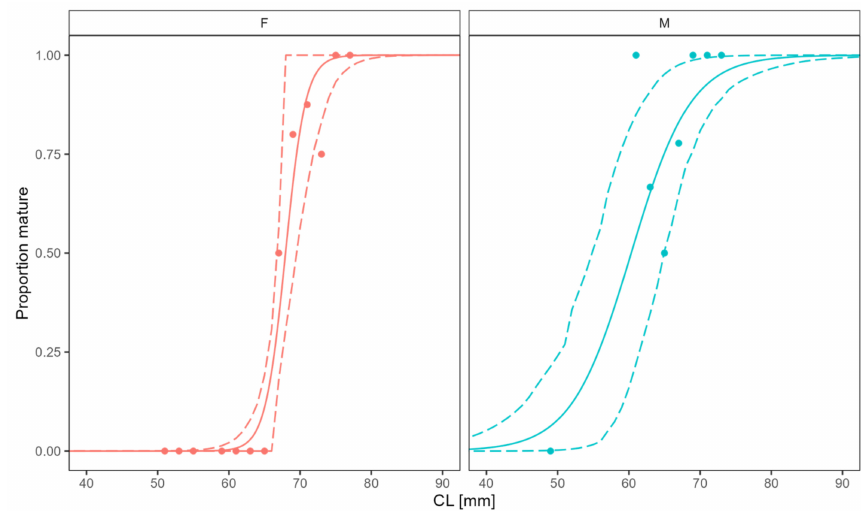
Figure 5. Maturity ogives for females (F) and males (M) of Calappa granulata collected from the central eastern Adriatic. The full line is the predicted maturity ogive over the size classes (carapace length) of the species, and the dotted lines show the bootstrapped 95% confidence intervals. Dots indicate observed proportions of mature